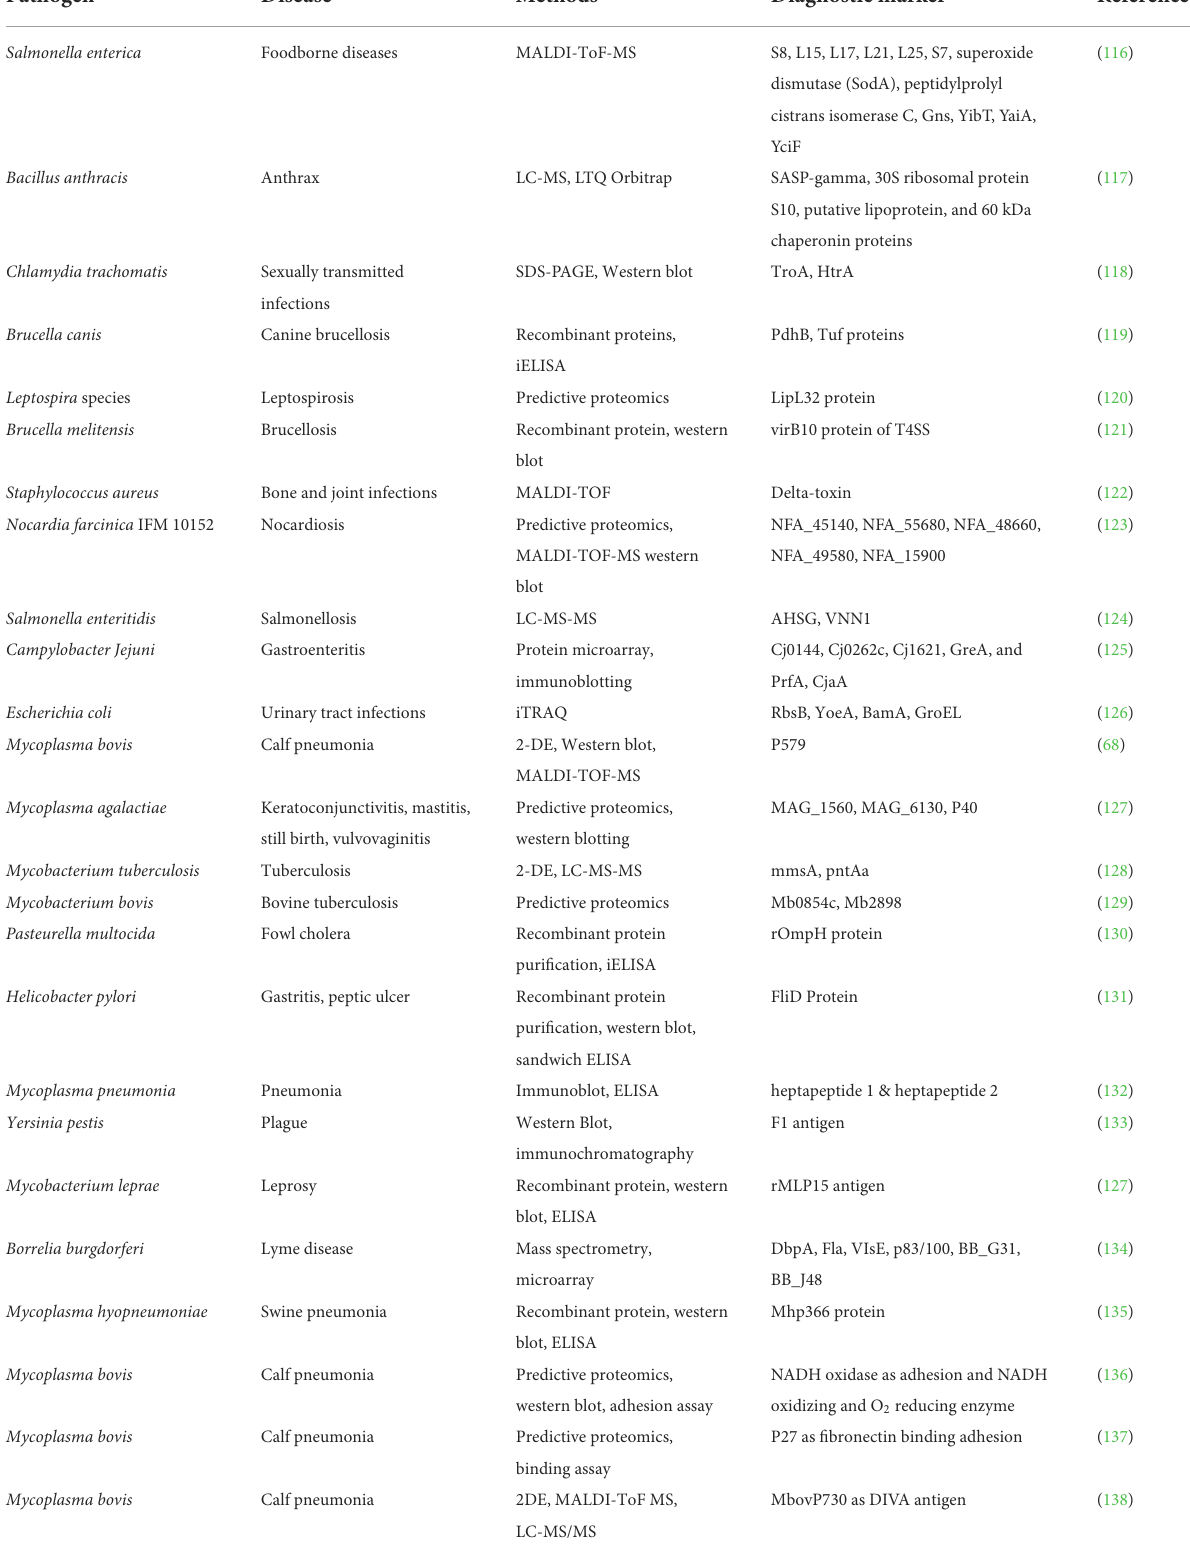
TABLE 1 Diagnostic markers of various important bacterial diseases using proteomics